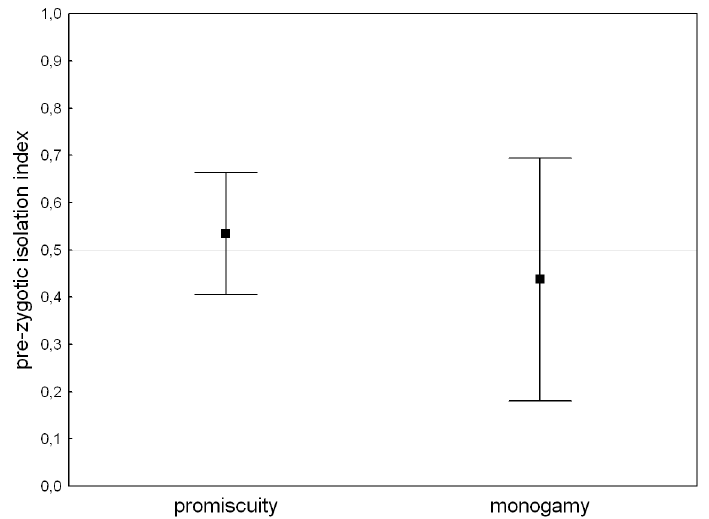
Figure 3. Pre-zygotic isolation indexes measured under male competition for monogamous and promiscuous mating system. Pre-zygotic isolation indices measured under male competition for monogamous and promiscuous mating system calculated from the mean indices for female lines. Indices values lower than 0.5 indicate that a male from the same line as a female fertilizes on average more eggs than a rival from different line. Bars indicate 95% confidence intervals.